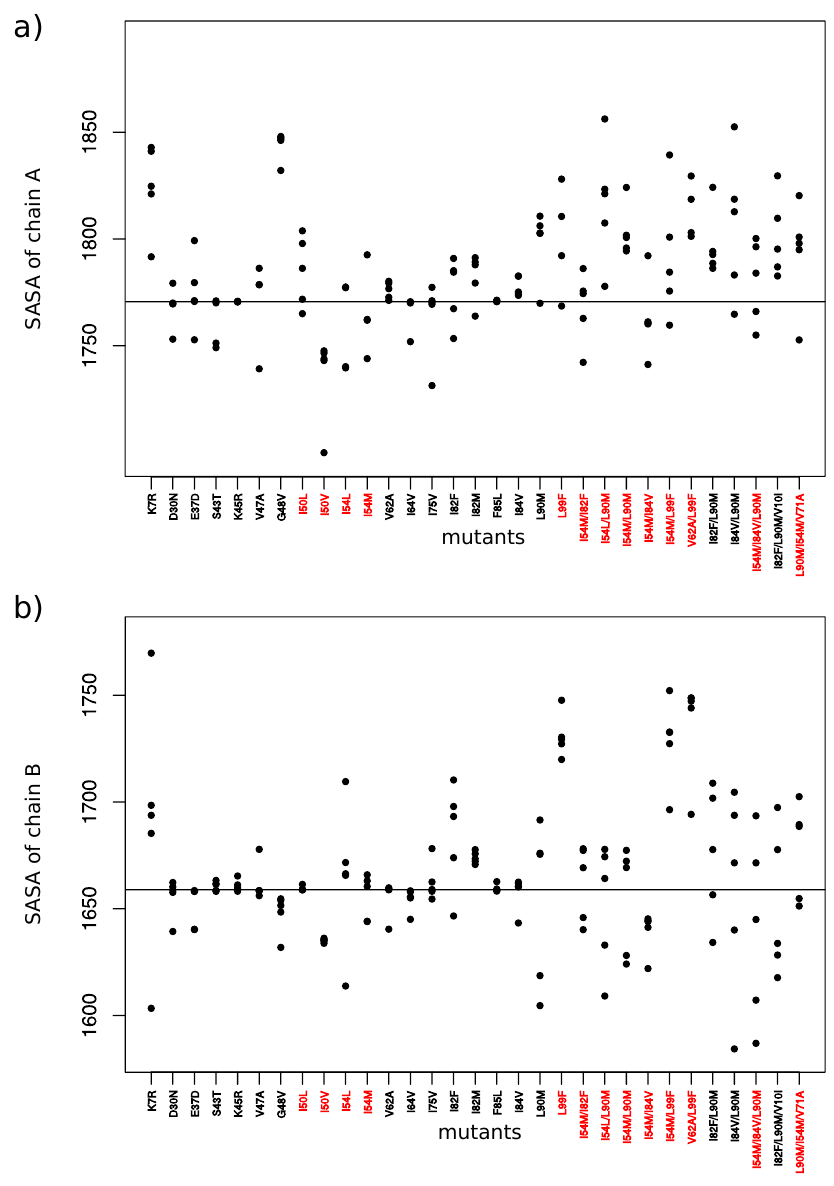
Figure 8. SASA values for interface of chain A ( a ) and chain B ( b ) for each mutant. Red mutants correspond to mutants having at least one mutation in PR2